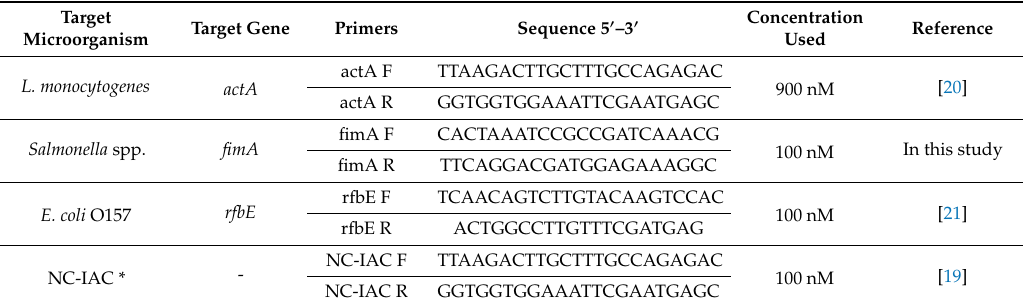
Table 2. Primer used in qPCR